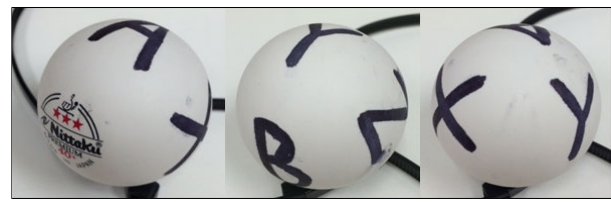
Figure 2. Alphabet markings on all balls used